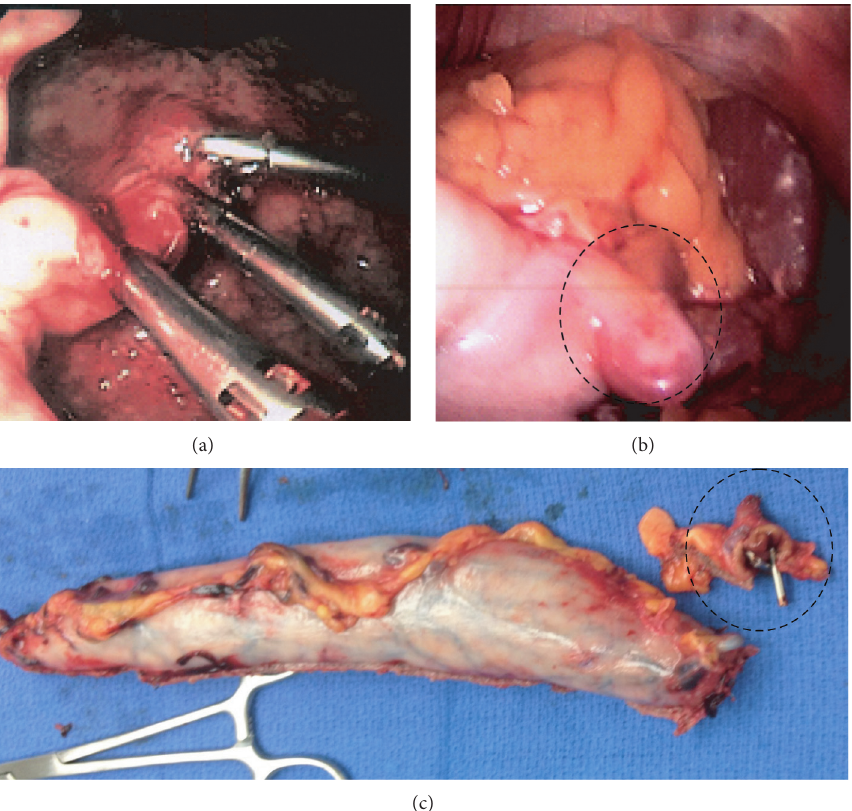
Figure 1: (a) Endoscopy: the bleeding Dieulafoy lesion is clipped. (b) Laparoscopy: a large blood vessel arising from the splenic artery enters the stomach wall. (c) Specimen: sleeve gastrectomy; in the smaller specimen, the endoscopic clips can be seen.